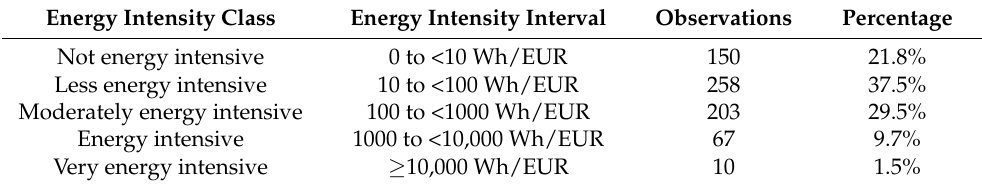
Table 3. Sample composition by energy intensity (n =